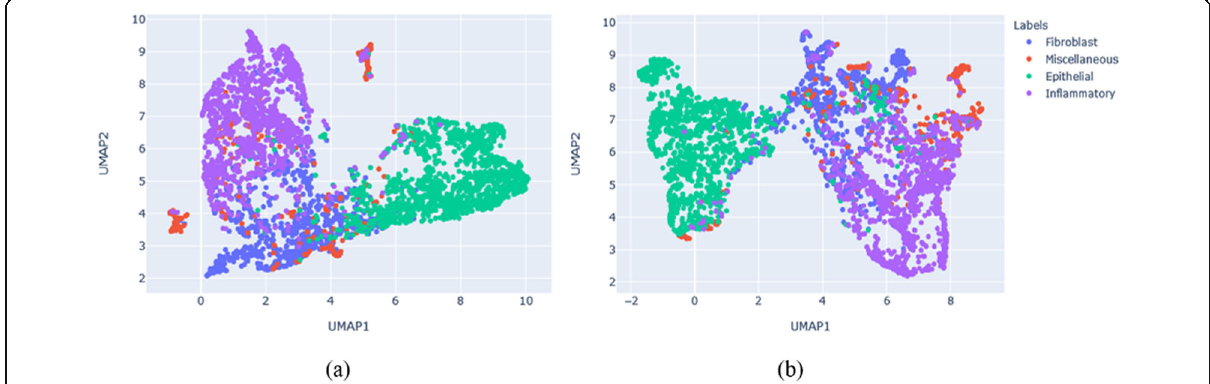
Fig. 11 Unsupervised analysis. a Clustering of deep features extracted with DenseNet. b Clustering of deep features extracted with